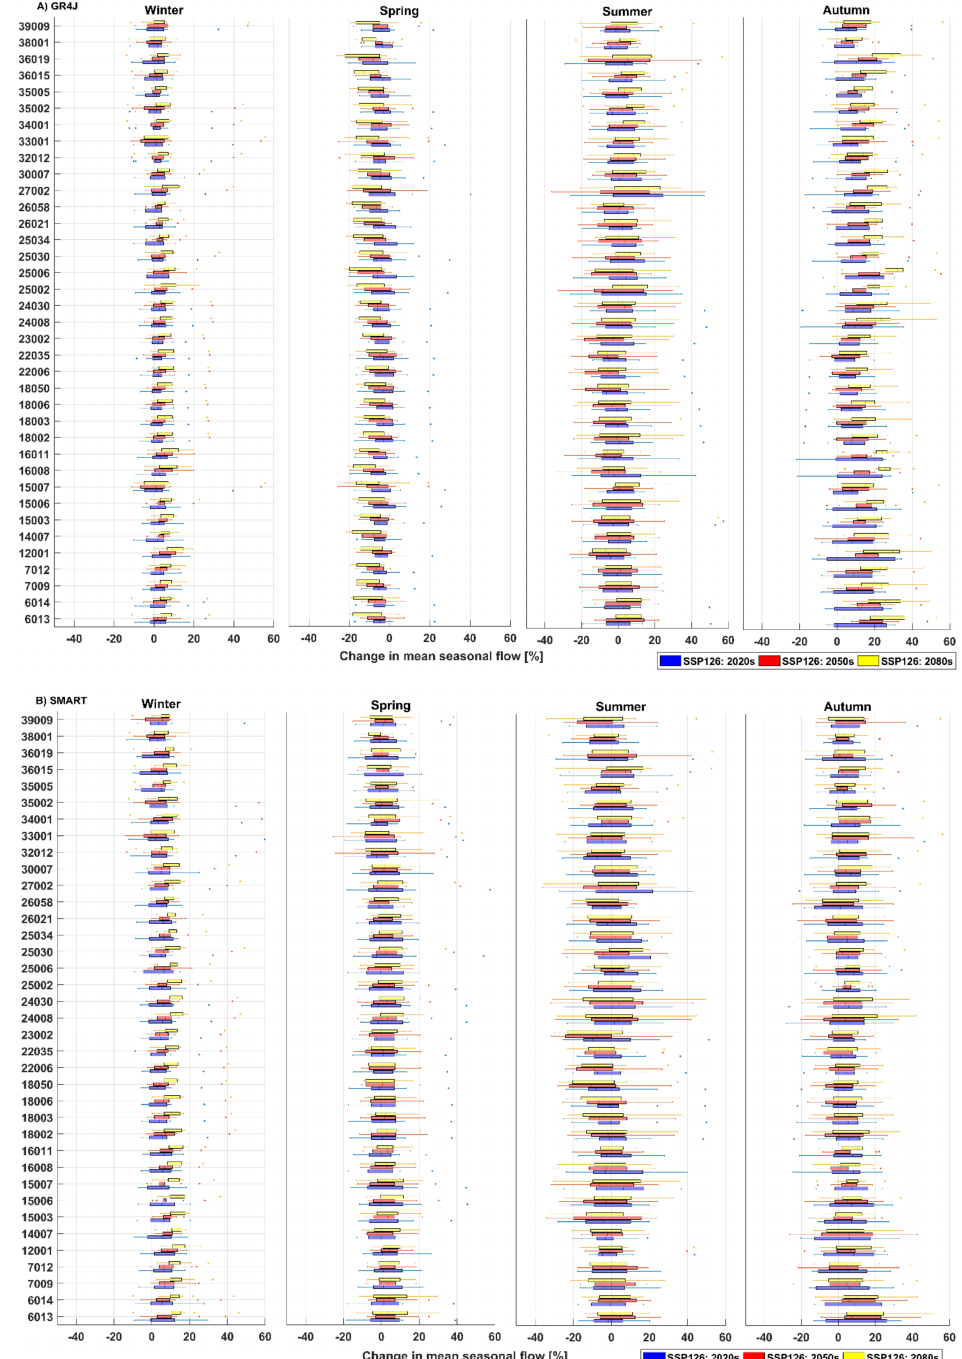
Figure 5. Projected percent changes in seasonal flows derived from the GR4J model ( A ) and SMART model ( B ) forced by the bias-corrected outputs from 12 CMIP6 models under SSP126 for the 2020s (blue), 2050s (red), and 2080s (yellow) relative to the reference period